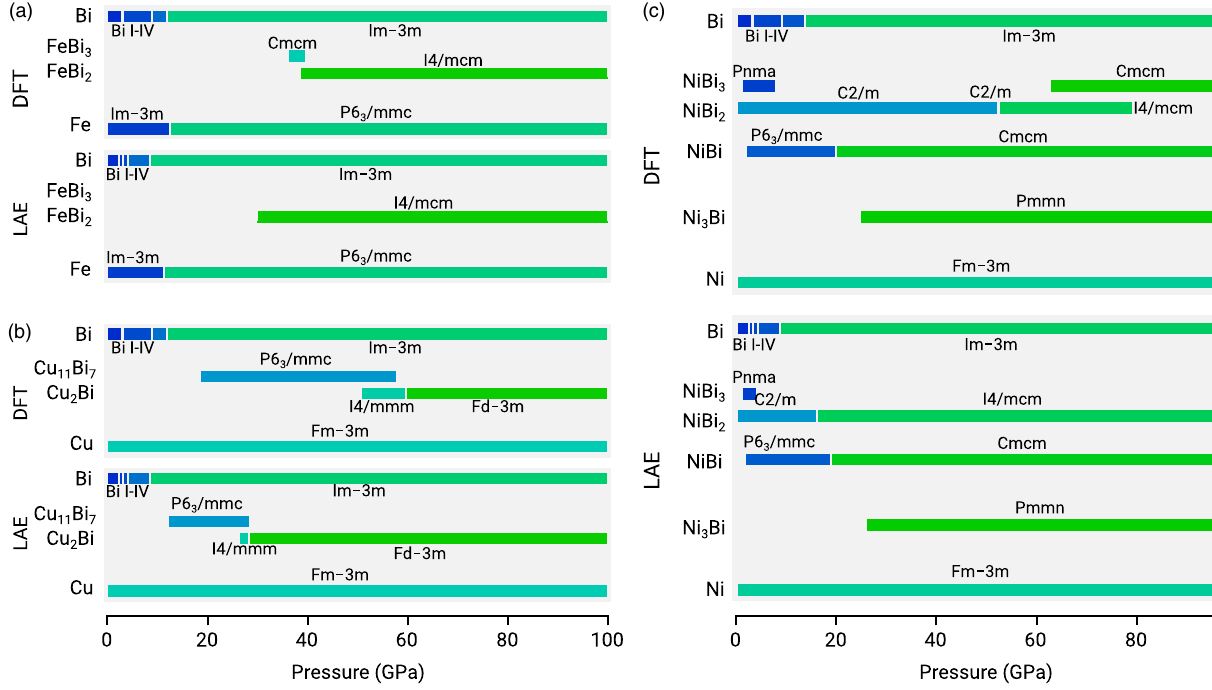
FIG. 3. Comparison between the explicitly computed phase diagrams with the ones derived from the LAE model for binary systems. Panels (a) – (c) correspond to the Fe – Bi, Cu – Bi, and Ni – Bi systems, respectively. Explicitly calculated transition pressures using DFTare denoted with “ DFT ” (top bar), and results based on the LAE are denoted with “ LAE ” (bottom